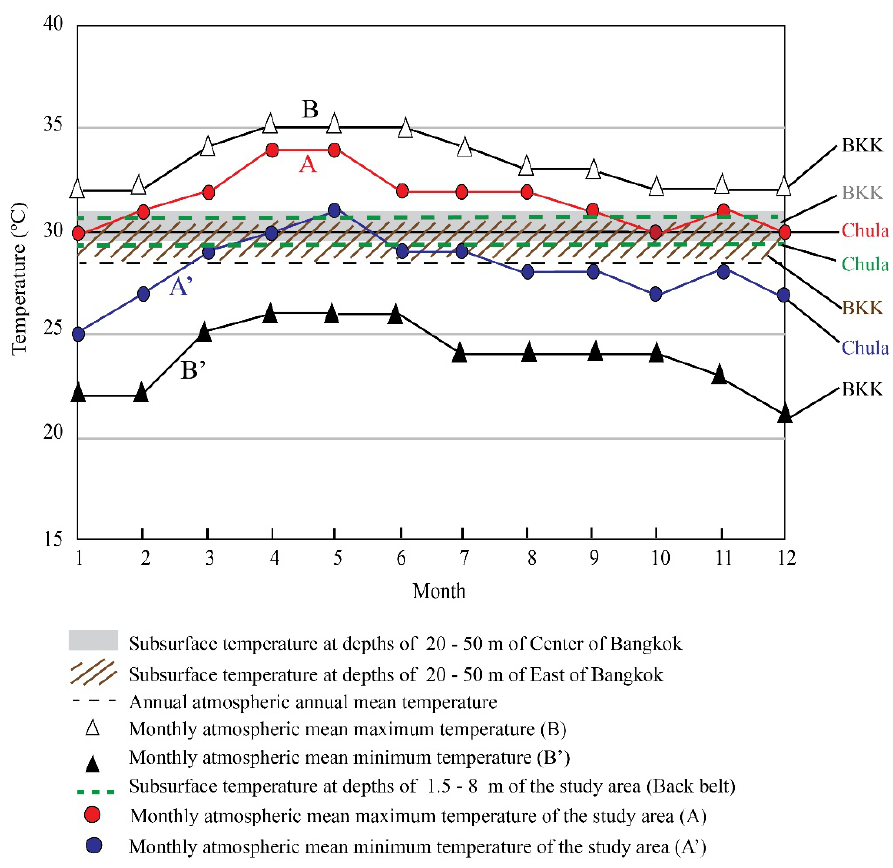
Figure 7. Comparison of atmospheric and subsurface temperatures of Bangkok area (modified after Yasukawa et al. [21]) and this study.